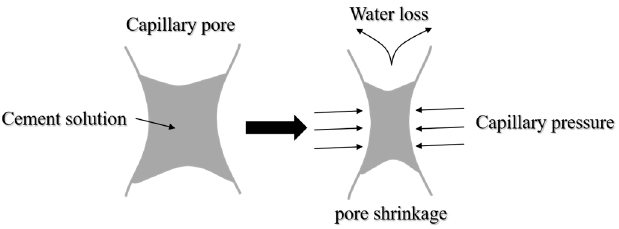
Figure 6. Schematic diagram of drying shrinkage of capillary of cement − based materials.